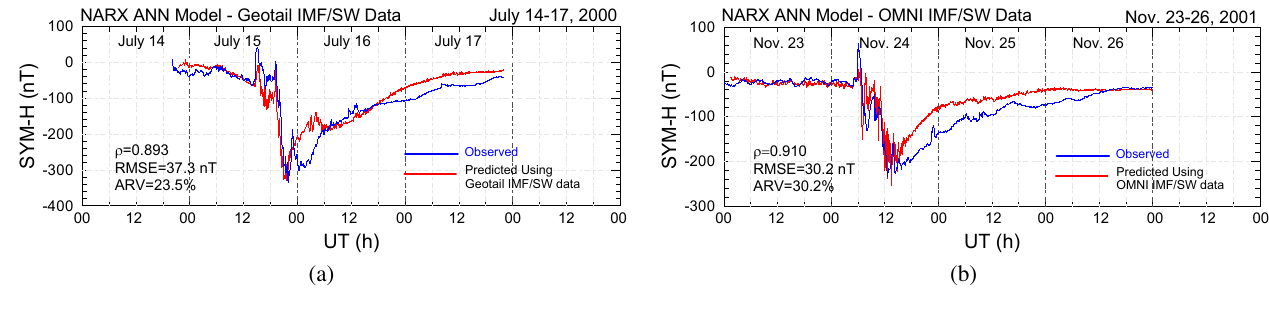
Fig. 8. Comparison of observed SYM-H index with that predicted by NARX neural network with 24 context units for testing storm events whose IMF/SW data are from Geotail and OMNI.